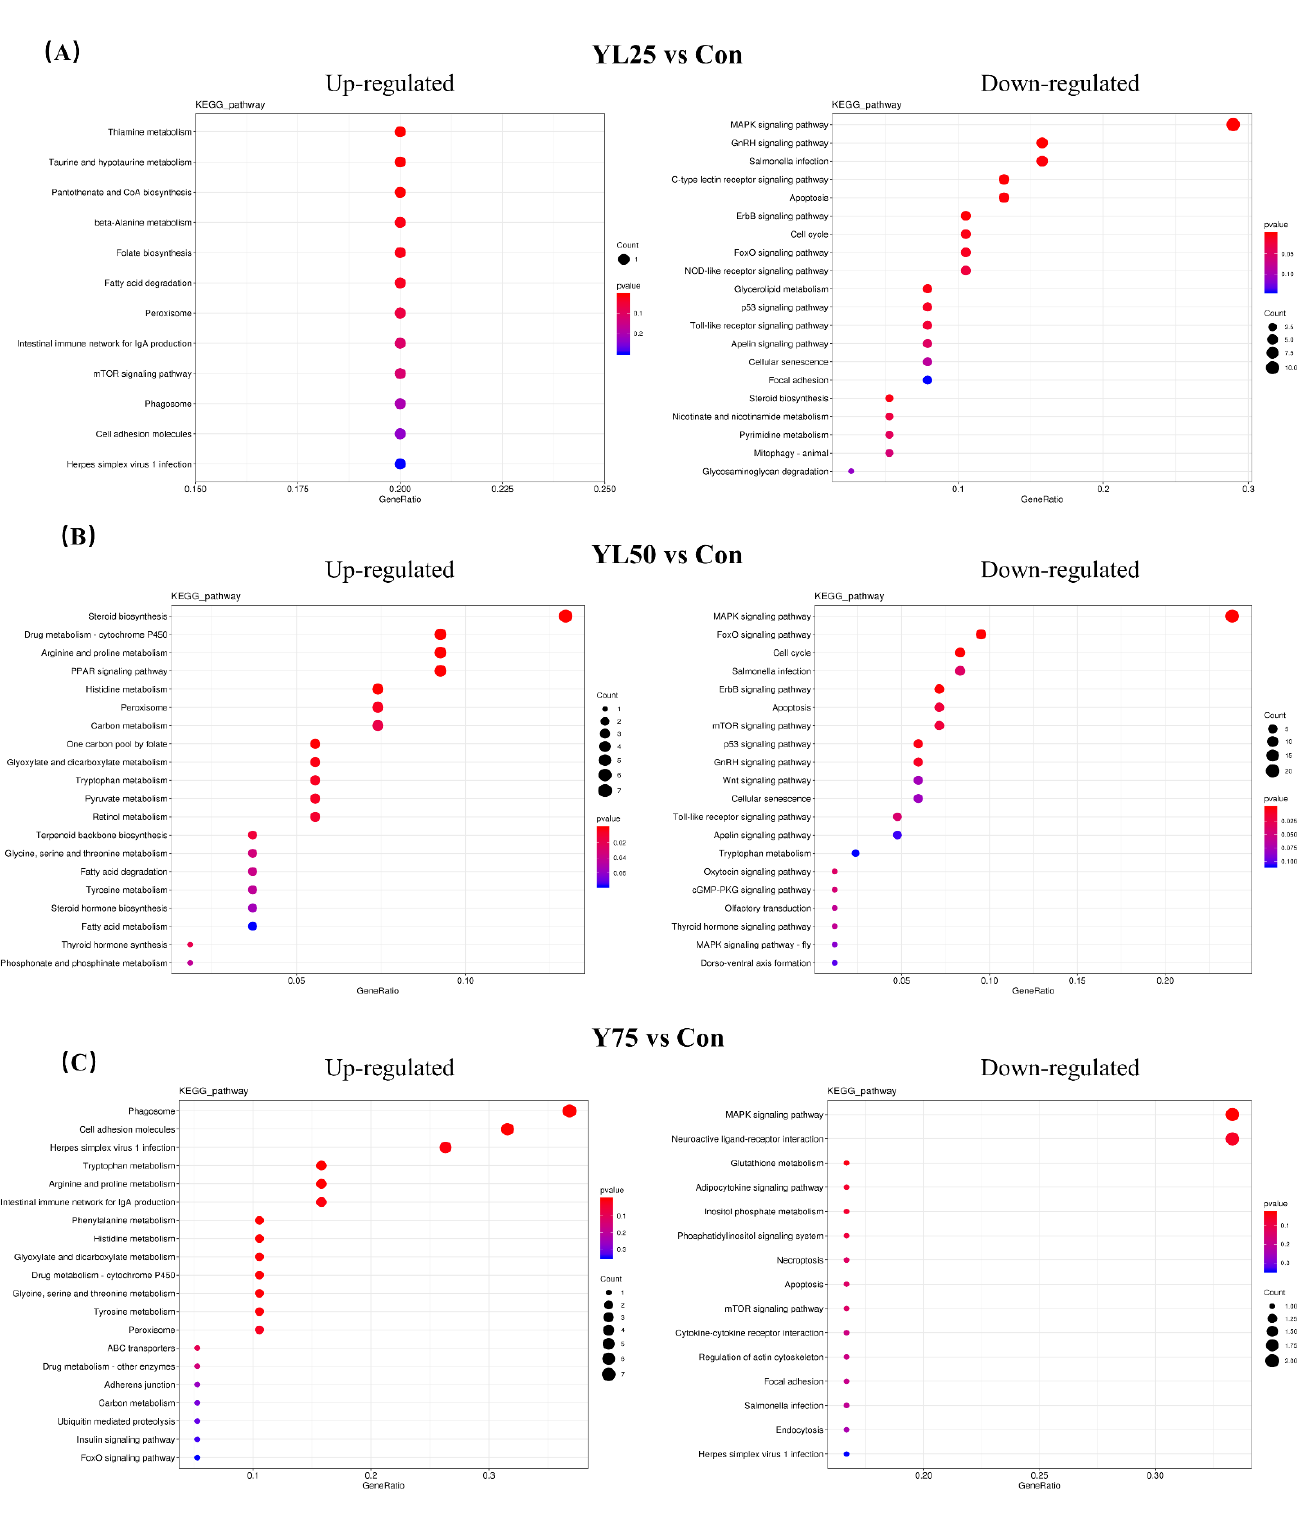
Figure 6. KEGG enrichment analysis of DEGs in transcriptome following dietary YL inclusion. ( A ) KEGG enrichment analysis of the regulated genes in the YL25 treatment. ( B ) KEGG enrichment analysis of the regulated genes in the YL50 treatment. ( C ) KEGG enrichment analysis of the regulated genes in the YL75 treatment. Con was the control diet. In the other three diets, 25%, 50%, 75% of the fish meal was replaced with YL. The diets were named YL25, YL50, and YL75, respectively.